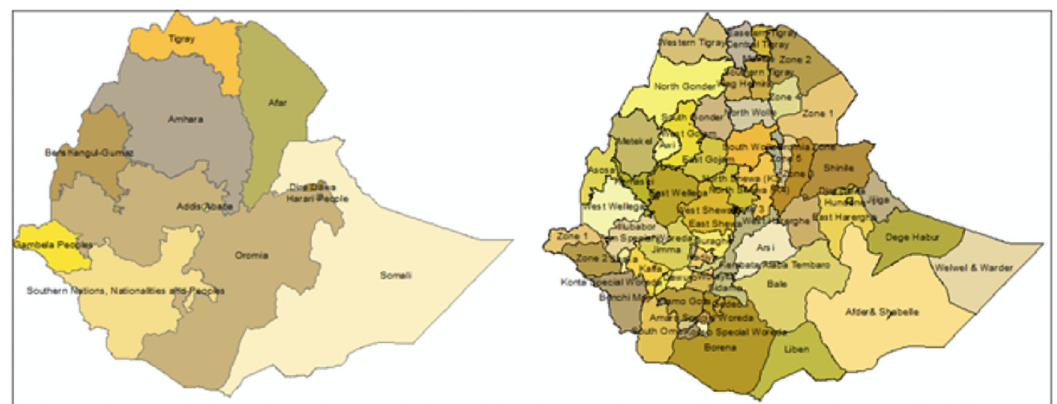
Fig 1. Map of Ethiopia and showing 11 regions and 72